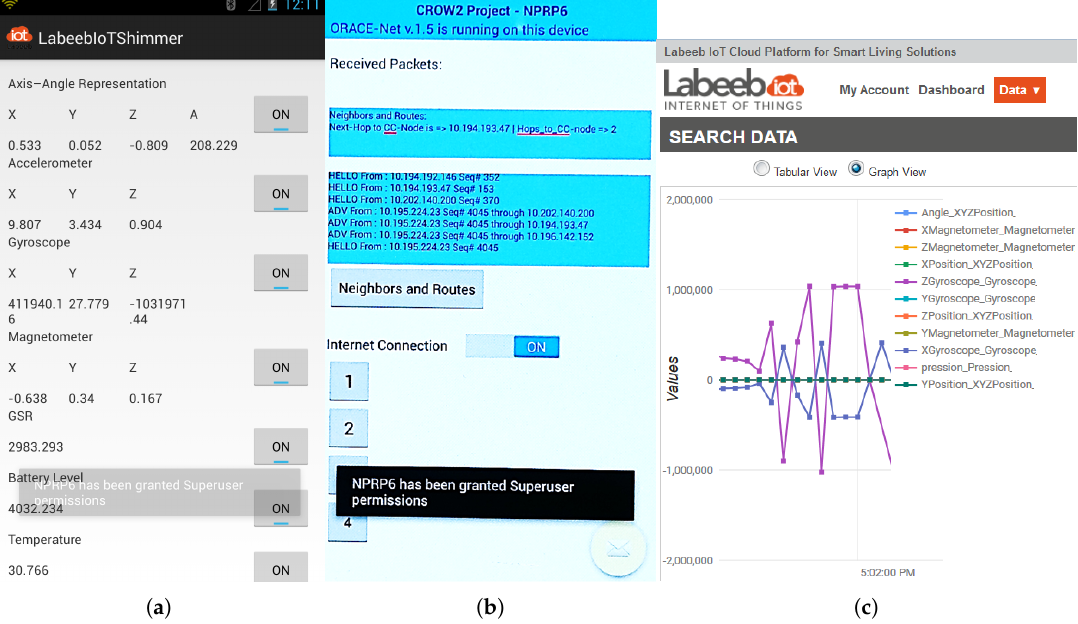
Figure 4. ( a ) A screen-shot from the Labeeb-IoT Shimmer sensing mobile app, which collects data from Shimmer [31] sensors and pushes them to the Internet of Things platform (Labeeb-IoT). ( b ) Testbed: a photo of the ORACE-Net mobile devices displaying the real-time events (received "Hello" and Advertisement ("ADV") packets) and the current route. ( c ) The Labeeb-IoT [32] interface shows the variation of the sensed data from the Shimmer sensor connected to the mobile